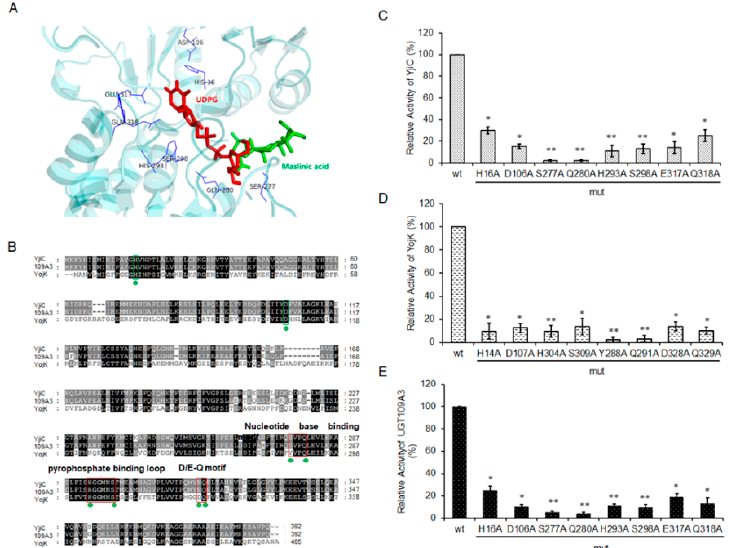
Figure 3. The key amino acids of YojK, YjiC, and UGT109A3. ( A ) Molecular docking of YjiC showing amino acid interactions with MA and UDPG. ( B ) Amino acids sequence alignment of YojK, YjiC, and UGT109A3. The green frame indicates the active sites His-Asp. The red frames indicate nucleotide base binding motif, pyrophosphate binding loop, and D/E-Q motif interacts with the UDP moiety. The green dots indicate the amino acids for site-directed mutagenesis. Effect of YjiC-mut ( C ), YojK-mut ( D ), or UGT109A3-mut ( E ) activity for MA glycosylation. * p < 0.05, ** p < 0.01 vs. wt.